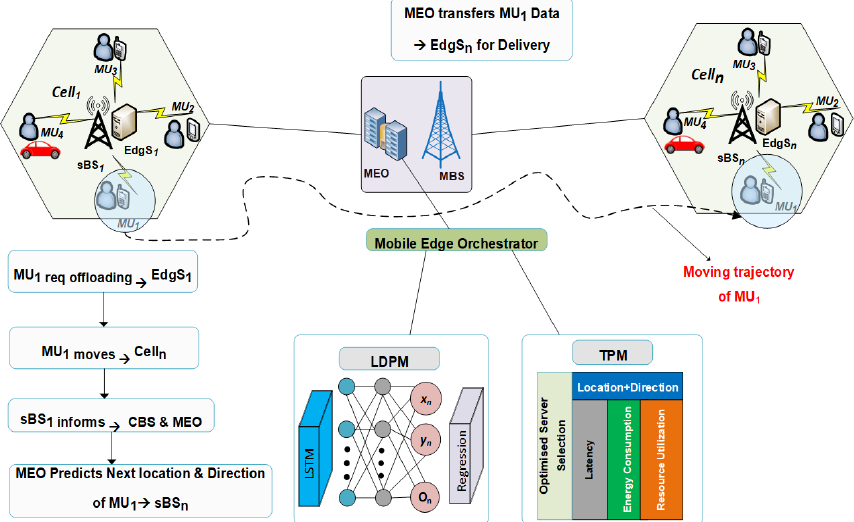
Figure 3. COME-UP architecture.